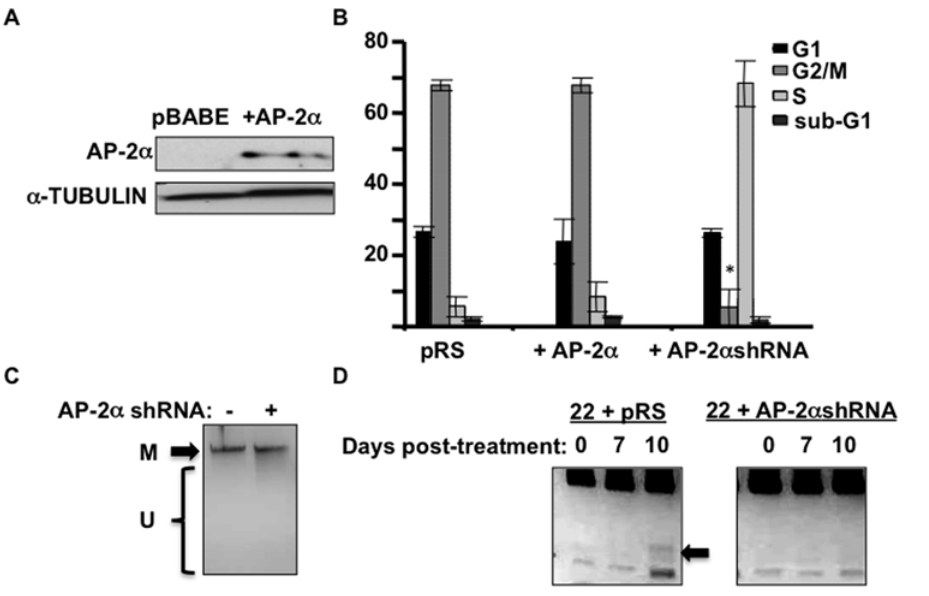
Figure 5. Decreased AP-2 a expression reduces proliferation; and AP-2 a is required for target remethylation following demethylation. a) AP-2 a western blot analysis of SCC22B cells with AP-2 a overexpression. b) Cell cycle analysis via flow cytometry comparing WT, AP-2 a -overexpressing, and AP-2 a -downregulated SCC22B cells. * P-value=0.0003. c) Methylation sensitive HhaI digests were performed on DNAs from SCC22B cells with and without AP-2 a downregulation, revealing no distinguishable difference in global DNA methylation. ‘‘M’’=methylated; ‘‘U’’=unmethylated. d) 1 m M 5-aza-2 9 deoxycytidine was applied to the cells for 96 hours, changing the media daily. After 96 hours, the 5-aza- 2 9 deoxycytidine was removed and the cells were continued in culture for 10 days, collecting cells at 0, 7, and 10 days post-treatment. Combined bisulfite restriction analysis on bisulfite-treated DNA obtained from these cells at 0, 7, and 10 days. Increased methylation at 10 days is seen in the AP-2 a -expressing cells (i.e. the digested band indicated by the arrow).